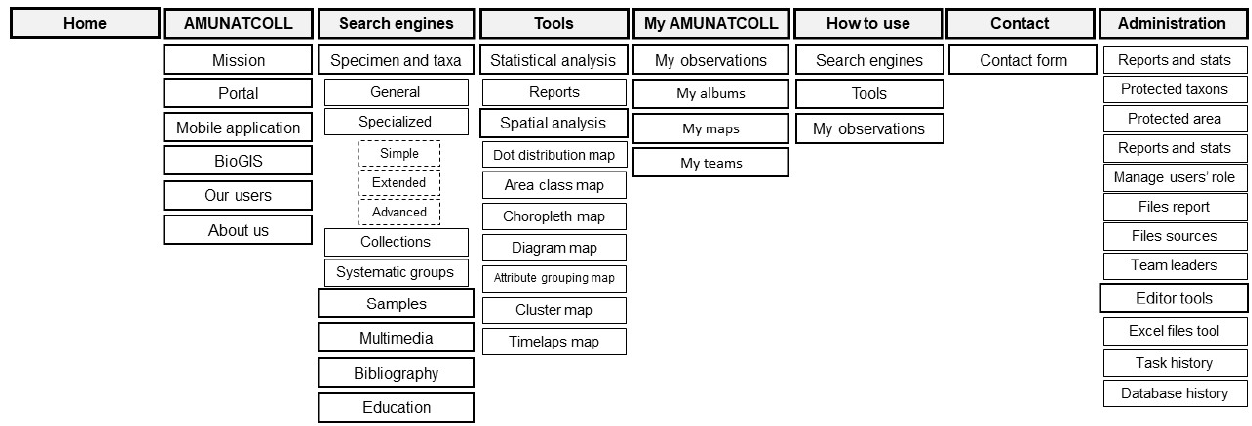
Figure 5. The architecture of the AMUNATCOLL portal.